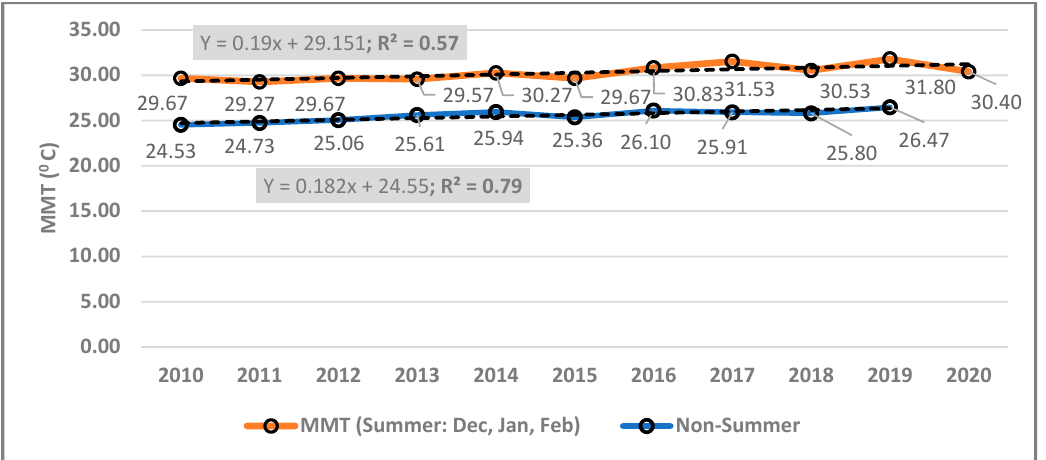
Figure 5. Trend of annual mean maximum temperature from 2000 to 2020.